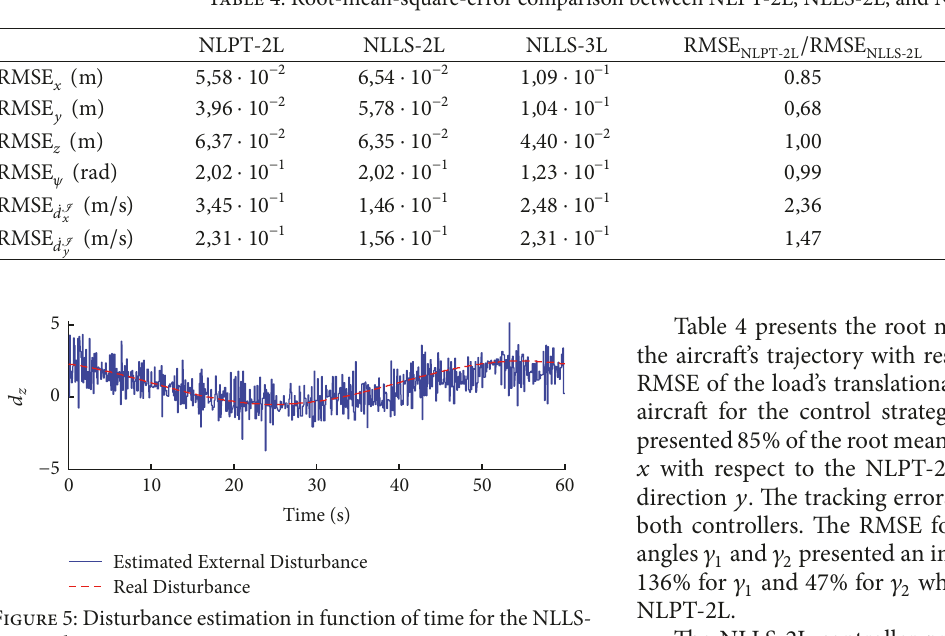
Table 4: Root-mean-square-error comparison between NLPT-2L, NLLS-2L, and NLLS-3L.